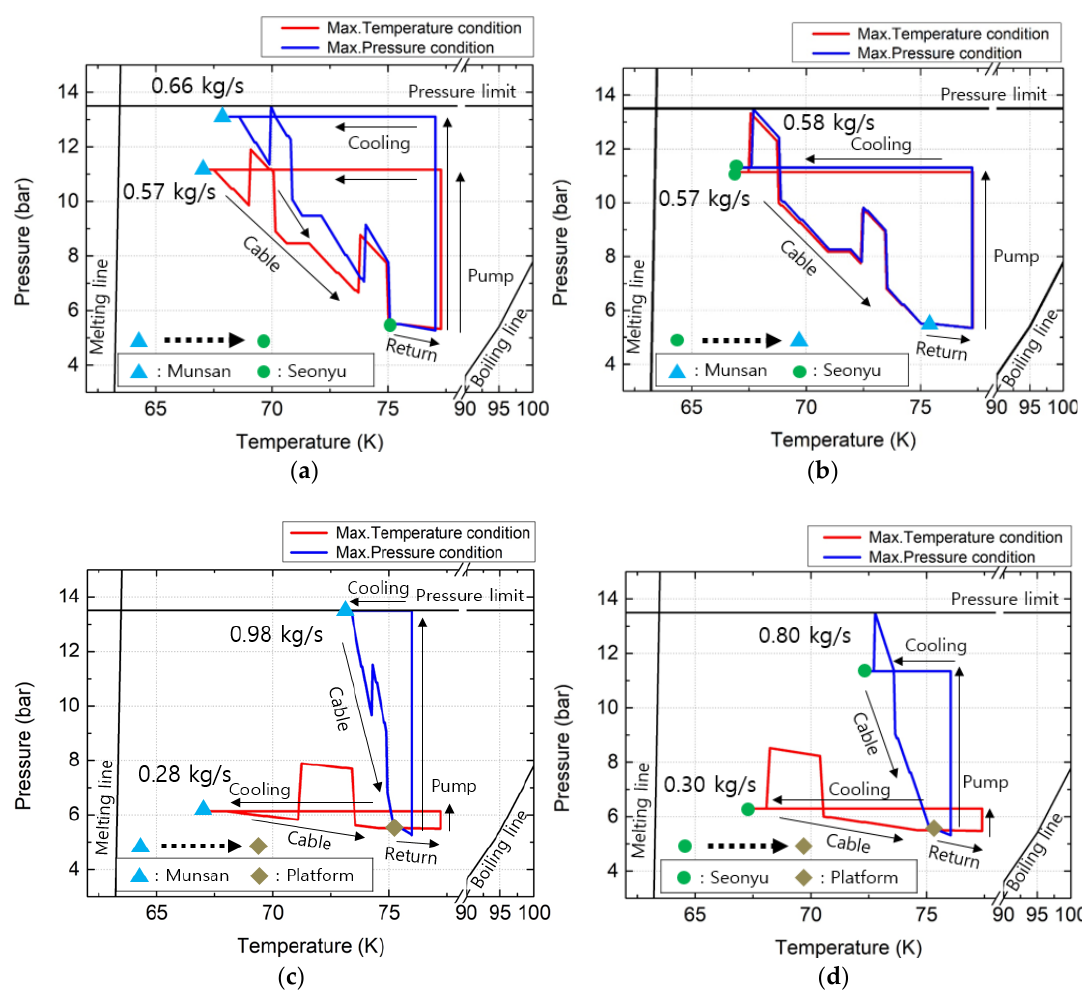
Figure 12. Possible operating range between pressure and temperature limit with external return path in phase diagram: ( a ) single cooling system at Munsan; ( b ) single cooling system at Seonyu; ( c ) dual cooling system, Munsan side; ( d ) dual cooling system, Seonyu side.